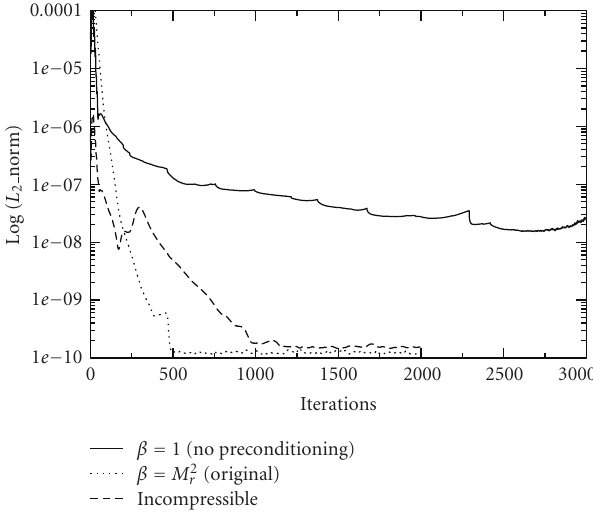
Figure 6: Convergence histories of SUBOFF bare